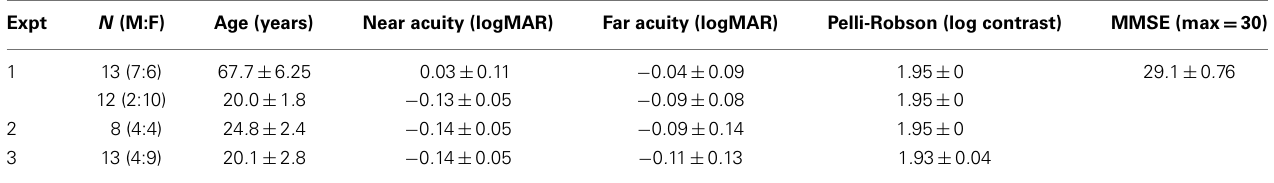
Table 1 | Mean ± 1 SD age, near and far logMAR acuity, Pelli-Robson contrast sensitivity, and Mini-Mental State Examination